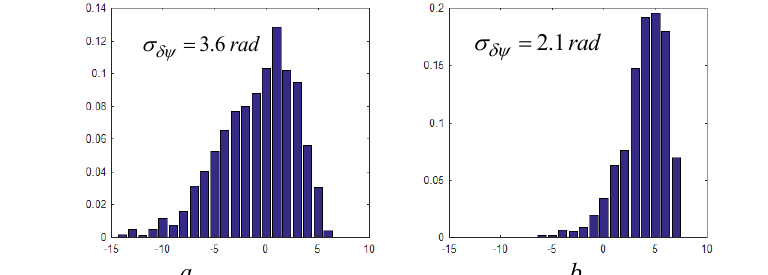
Fig. 1 . The spatial distribution of the recovered absolute phase and the absolute reference phase differences: a) before vertical alingment; b) after vertical alingment.